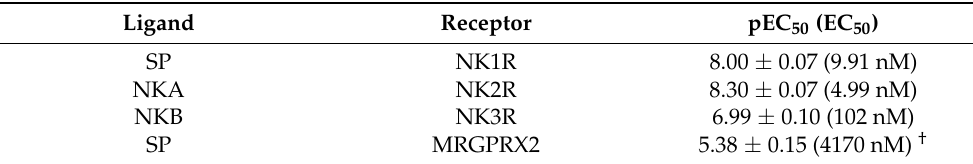
Table 1. Dose–response parameters for stimulation of cells expressing NK1R, NK2R, NK3R and MRGPRX2 with cognate native tachykinin ligands.